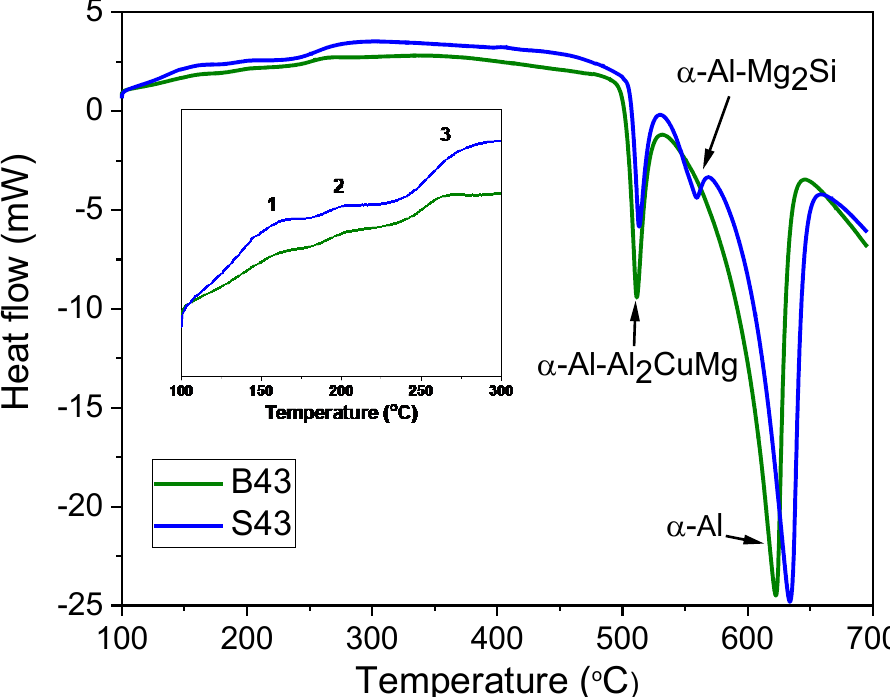
Figure 2. Differential scanning calorimetry (DSC) curves of the investigated alloys, which were ◦ C per heated at a rate of 10 °C per minute. heated at a rate of 10